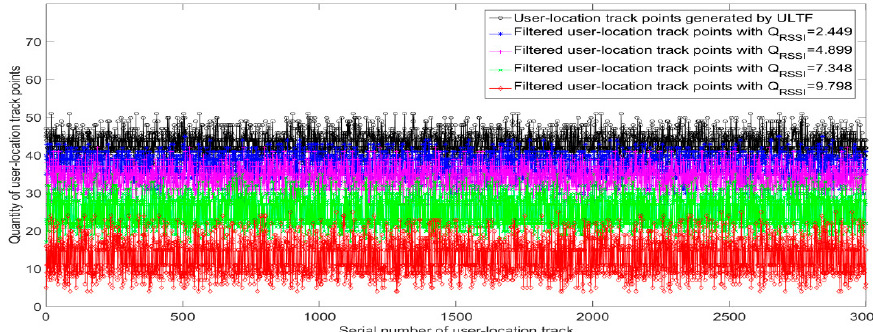
ff erent Q RSSI